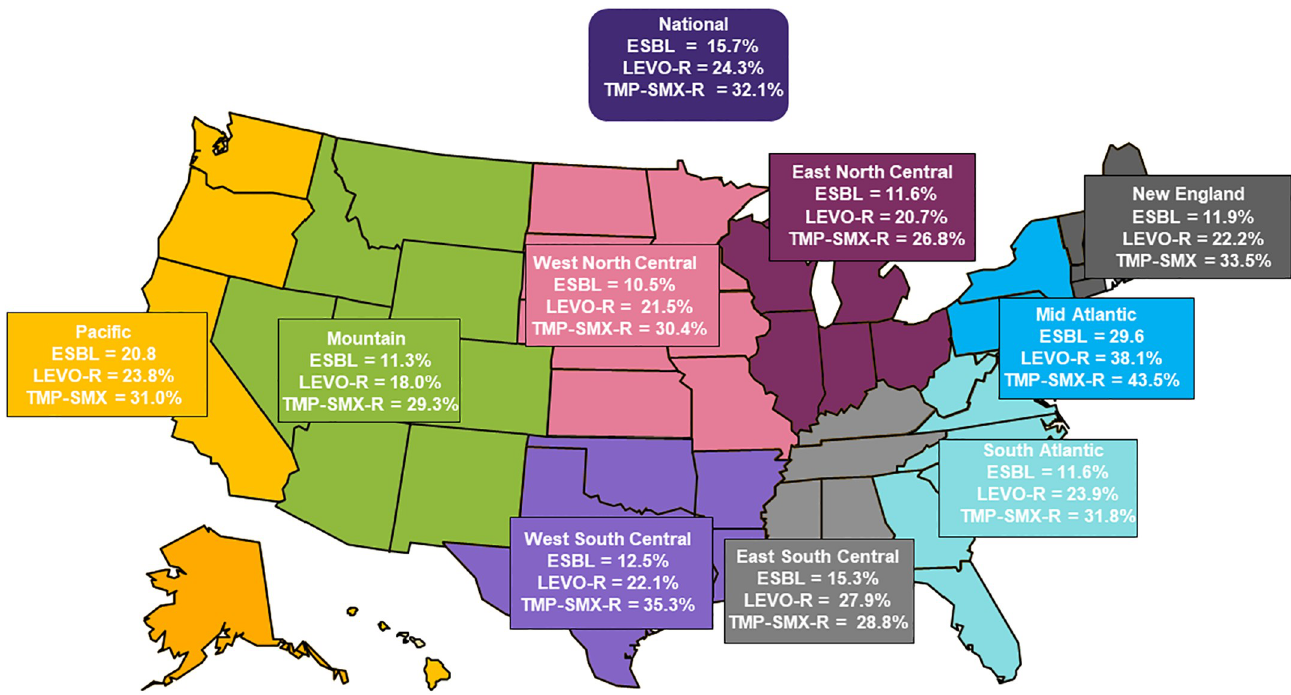
Fig 1. National and regional prevalence of ESBL phenotypes, levofloxacin- and trimethoprim-sulfamethoxazole-resistant phenotypes among 1831 isolates of E . coli from UTIs in the USA in 2017. ESBL = extended spectrum β -lactamase, LEVO-R = levofloxacin-resistant, TMP-SMX-R = trimethoprim-sulfamethoxazole- resistant.